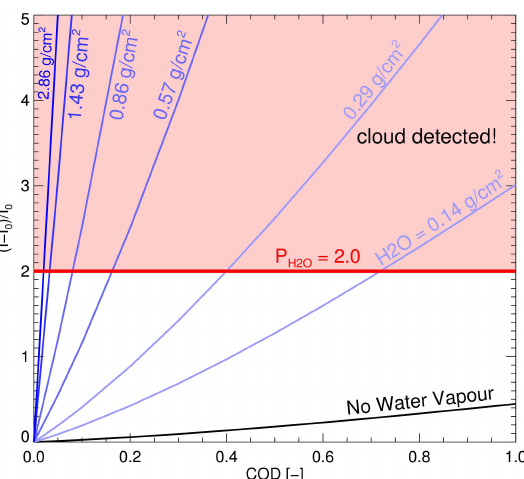
As described by Schneising et al. (2011) for